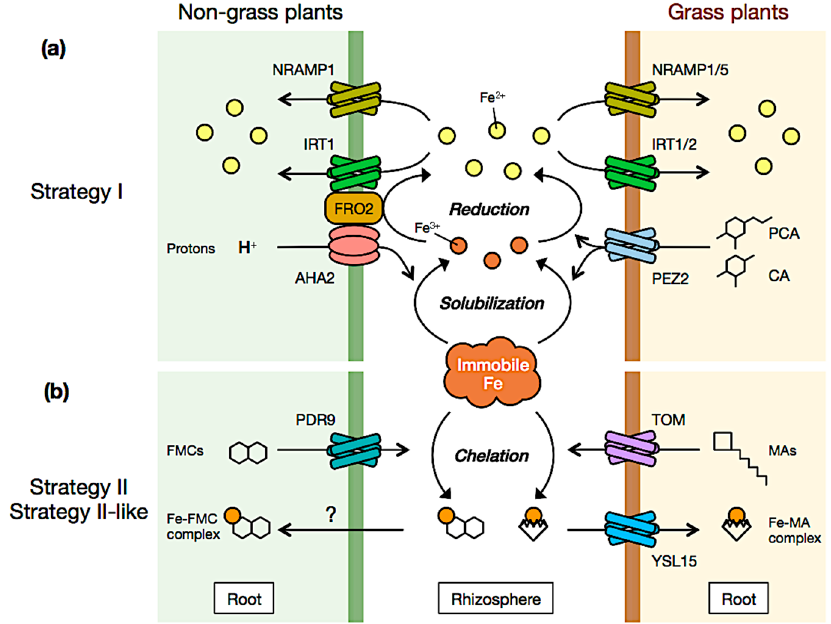
Figure 1. Iron uptake strategies in plants, not so different after all. ( a ) Strategy I, also called the reduction-based strategy, was first described as specific to non-grass species. In Arabidopsis, AHA2 (H + -ATPase) secretes protons into the rhizosphere to solubilise Fe 3+ which is then reduced into Fe 2+ by the ferric reductase FRO2. Fe 2+ is then uptaken into the plant root via IRT1 and to a lesser extent NRAMP1. Recent findings highlighted that the solubilization/reduction steps can be achieved in